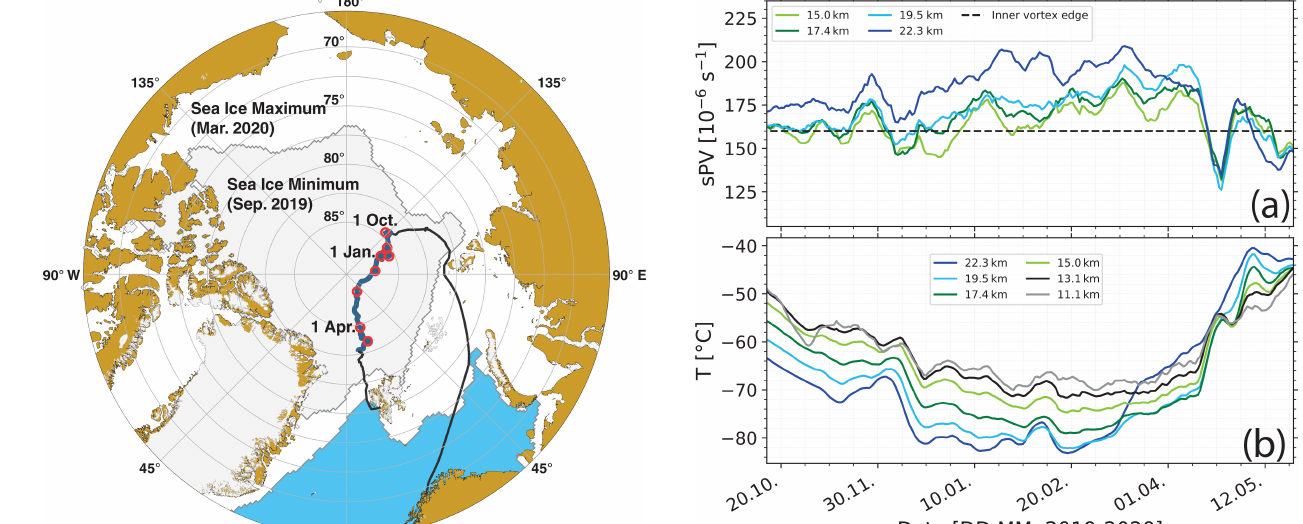
Millán et al. (2021). A sPV value of > 160 × 10 − 6 s − 1 (Bog- nar et al., 2021) indicates that the Polarstern was below the polar vortex from January until 20 April 2020 when the vor- tex began to